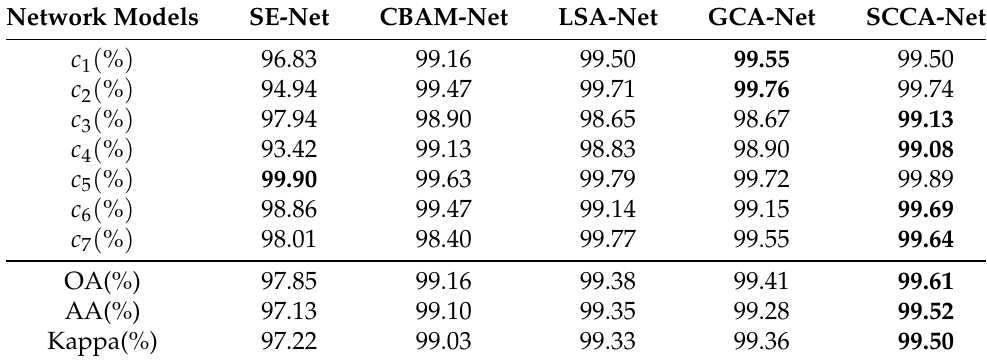
Table 3. Quantitative comparison over different network models on the Xi’an Urban image